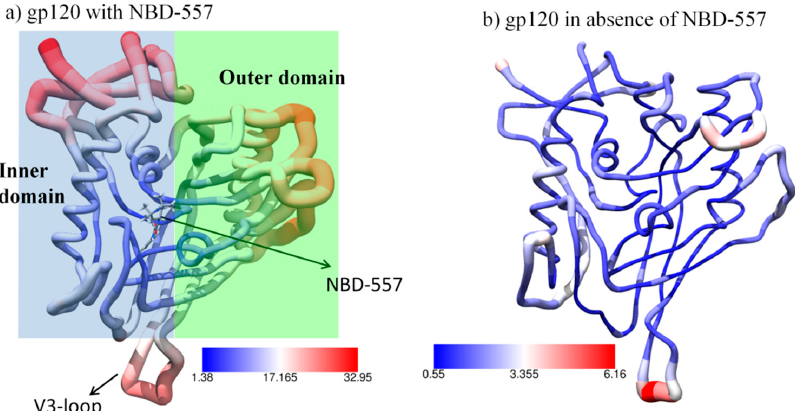
Figure 2. The root mean square fluctuations for gp120 shown in a worm model. The thickness of the worm radius represents the value of fluctuations ( a ) with NBD-557; the inner and outer domains are highlighted by blue and green transparent rectangles ( b ) without NBD-557. The values of RMSF (Å 2 ) are shown by colour keys in each